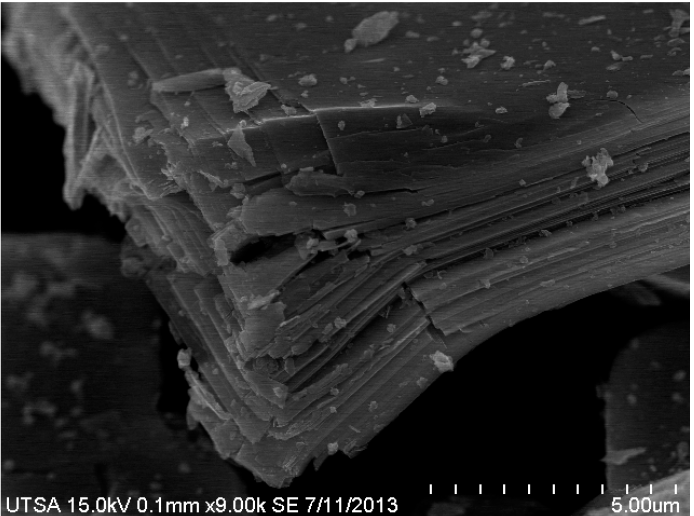
Figure 1. SEM image of the starting material K 4 Nb 6 O 17 , one can observed the nanosheets